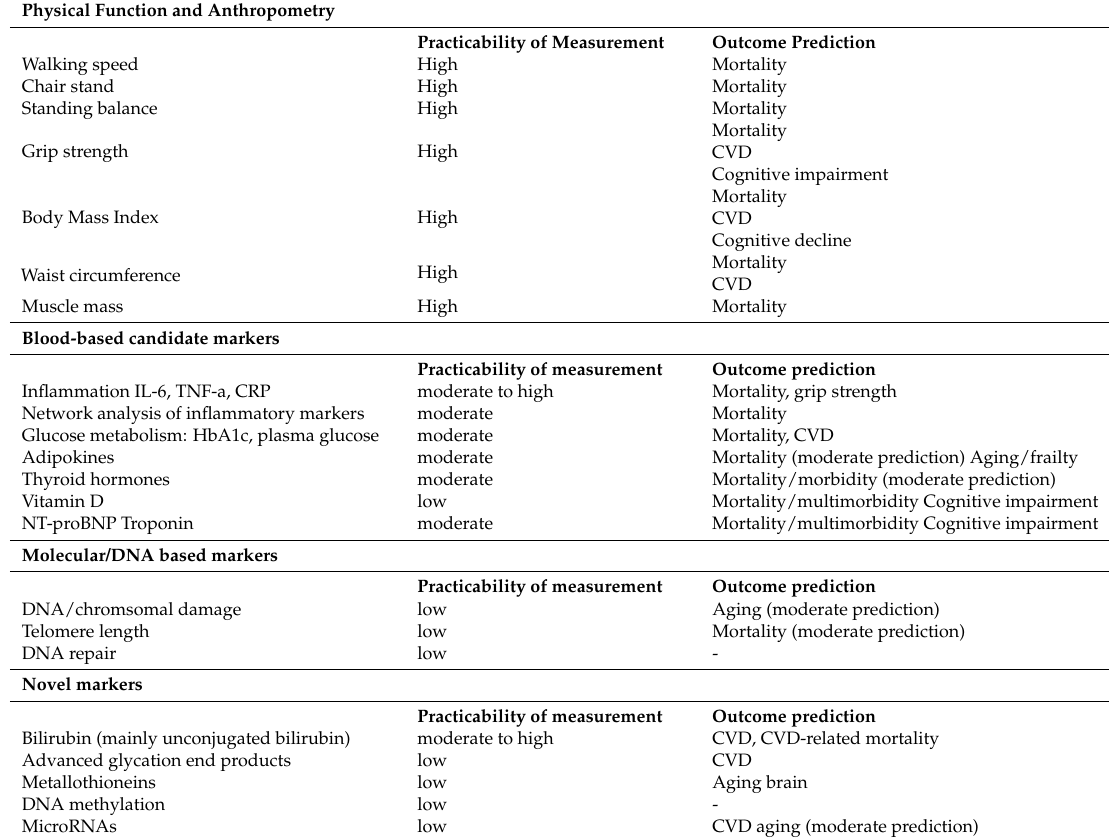
Table 1. Summary of putative biomarkers of